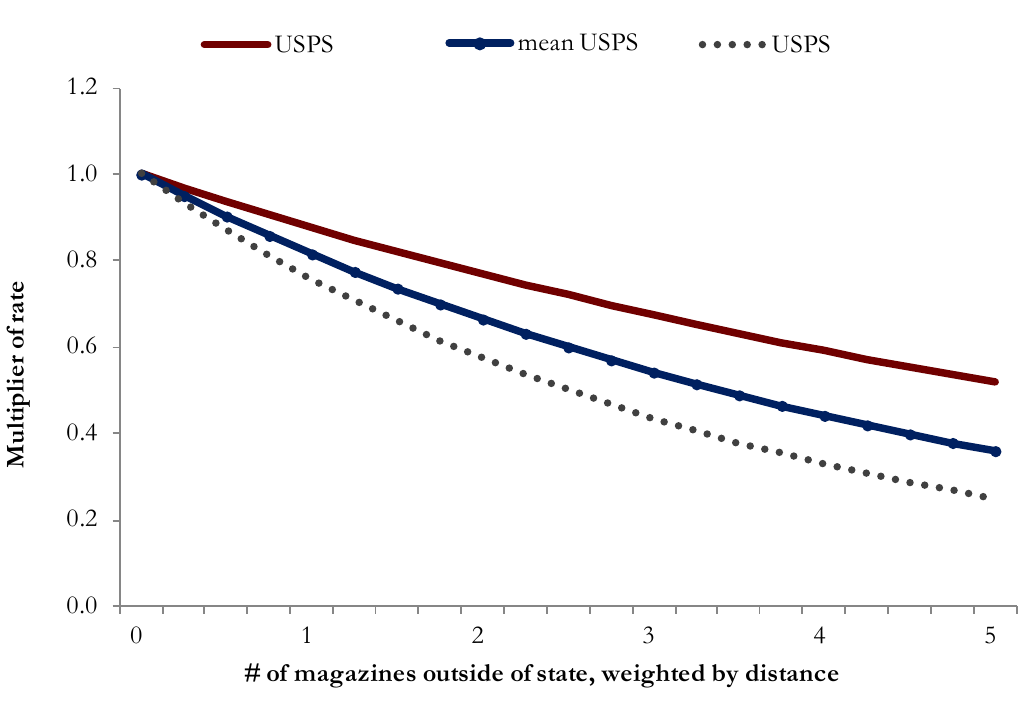
Figure 1b: The effect of out-of-state magazines on founding